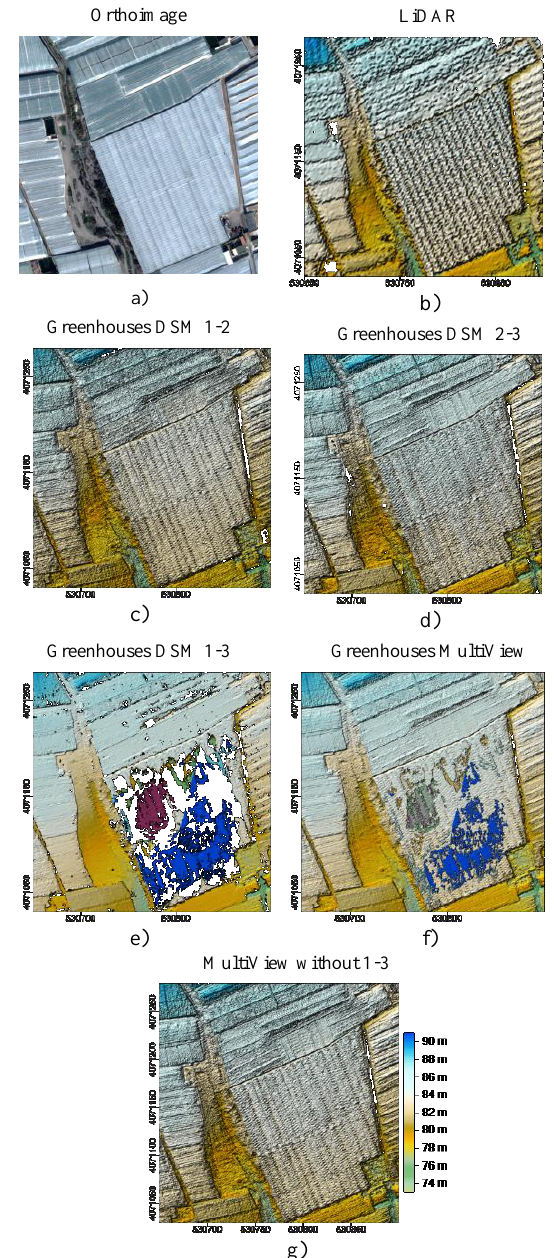
Figure 5. DSMs extracted for the plastic greenhouses land cover: a) WV3 RGB orthoimage; b) LiDAR data; c) DSM 1-2; d) DSM 2-3; e) DSM 1-3; f) DSM MultiView; g) Multiview without